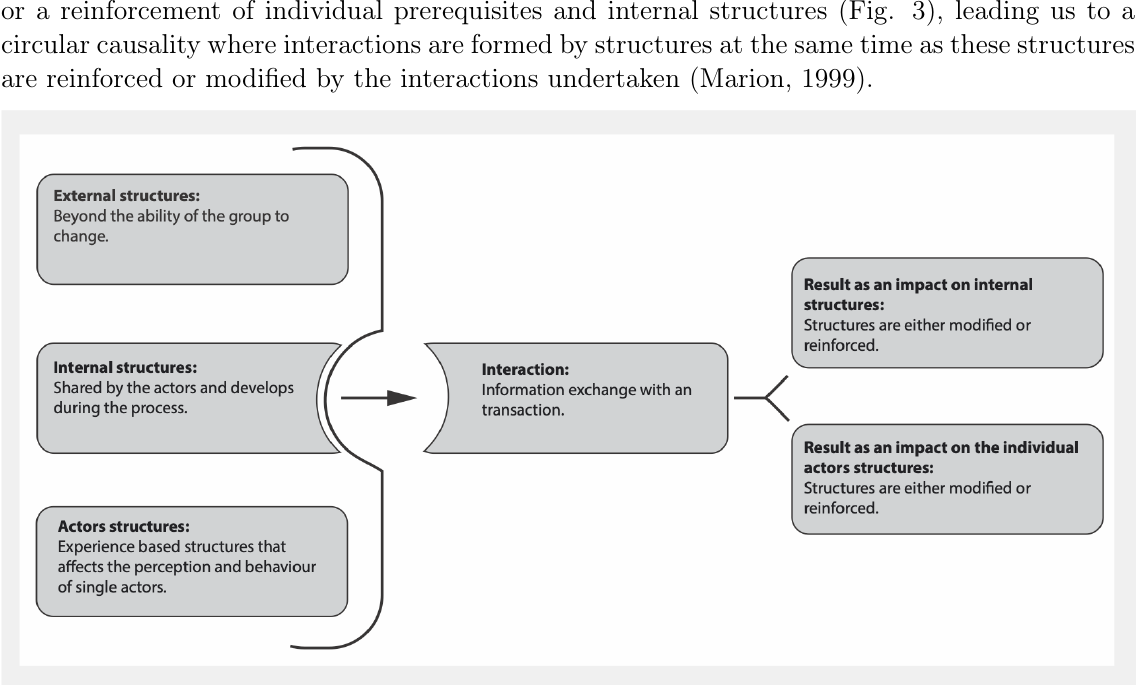
Fig. 2. Visualization of structures impacting the assessment groups (inspired by "Fig 5.2 Organisation ur ett perspektiv av social interaktion [Organisation from the perspective of social interaction]" from Backström, Döös & Wilhelmson 2006).